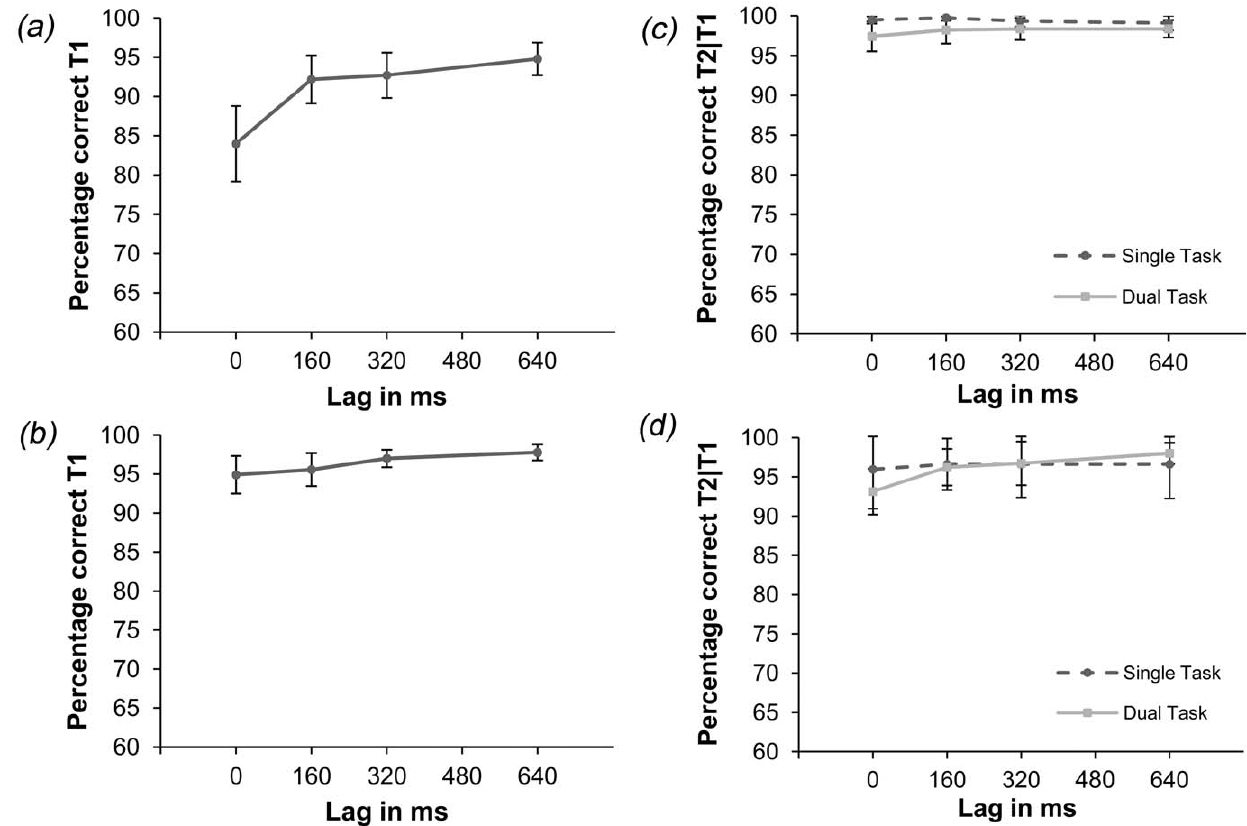
Figure 3. Results of Experiment 2. Panel (a) Percentage correctly identified letters in the dual-task condition of Experiment 2a. Significantly less letters are correctly identified for lag 0 ms compared to lags 320 ms and 640 ms. Panel (b) Percentage correctly identified letters in the dual-task condition of Experiment 2b. T1-identification was constant over all lags. Panel (c) T2 detection performance in percentage correct in the single- and dual-task conditions of Experiment 2a. Scores for the dual-task condition are for correct letter identification. No difference between conditions was detected. Note that in this figure chance level is 50%. Panel (d) T2-detection performance in percentage correct in the single- and dual-task conditions of Experiment 2b. Scores for the dual-task condition are for correct letter identification. No difference between conditions was detected, however performance for lag 0 ms was lower compared to lag 640 ms. Note that in this figure chance level is 50%. Error bars reflect 95% confidence intervals in every